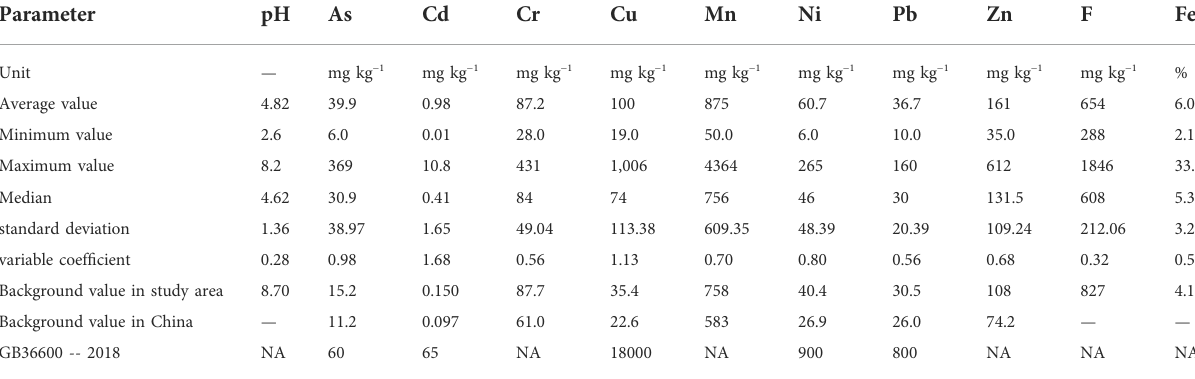
TABLE 2 Descriptive statistics of the soil PTE concentrations in the study